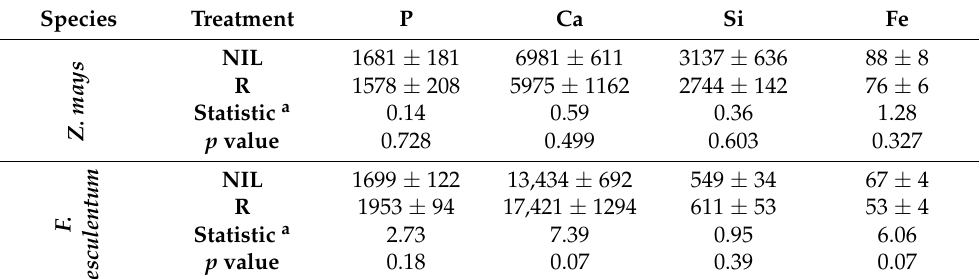
Table 3. Effect of soil inoculation on concentration ( µ g/g) of selected nutrients in shoots of test plant